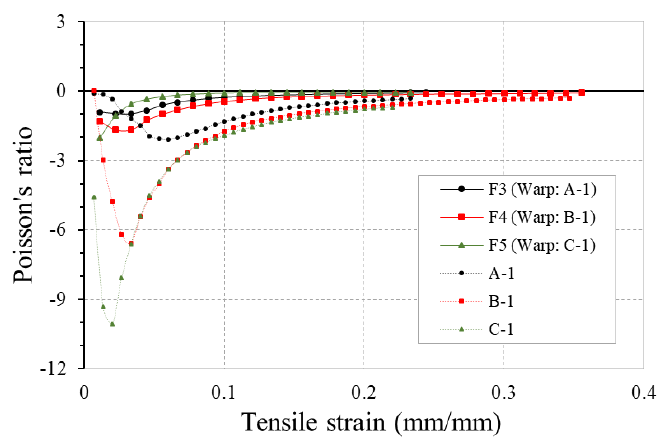
Figure 15. PR-tensile strain curves of fabrics F3, F4, F5 and their respective 4-ply auxetic yarns.